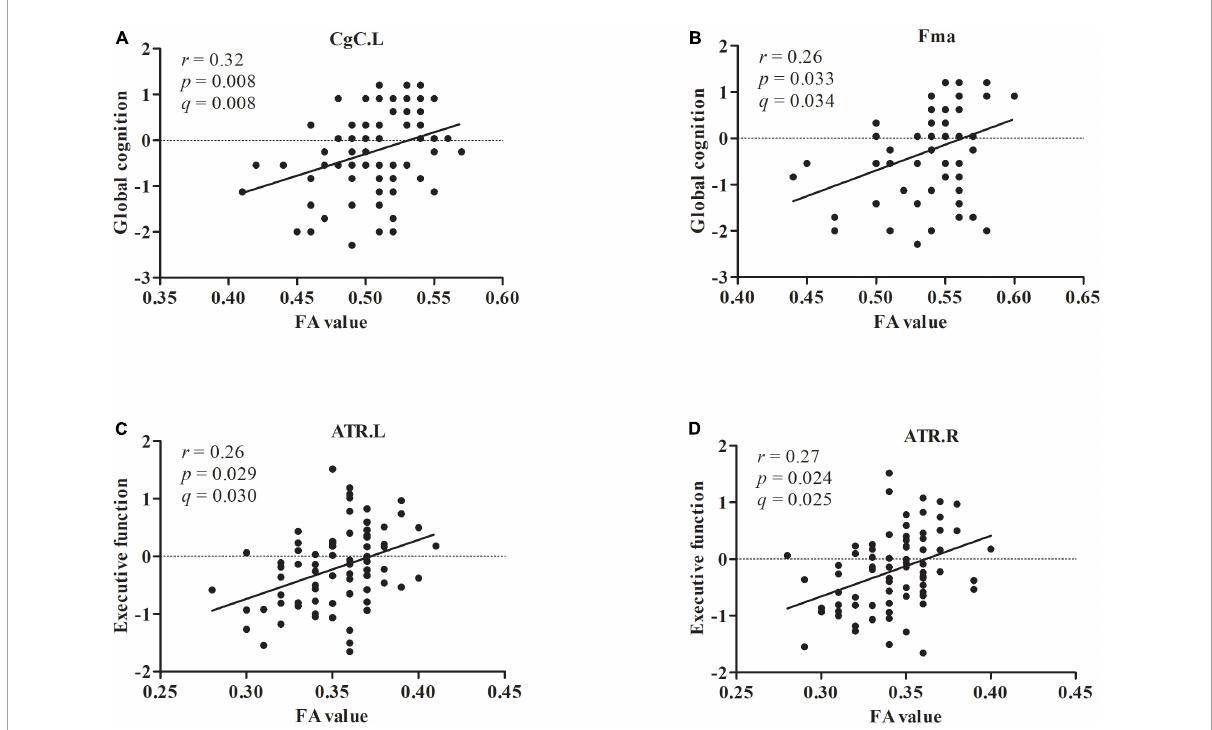
FIGURE2 The FA value in CgC.L and Fma displayed positive associations with global cognition (A,B) . The FA value in ATR.L and ATR.R displayed positive associations with executive function (C,D)